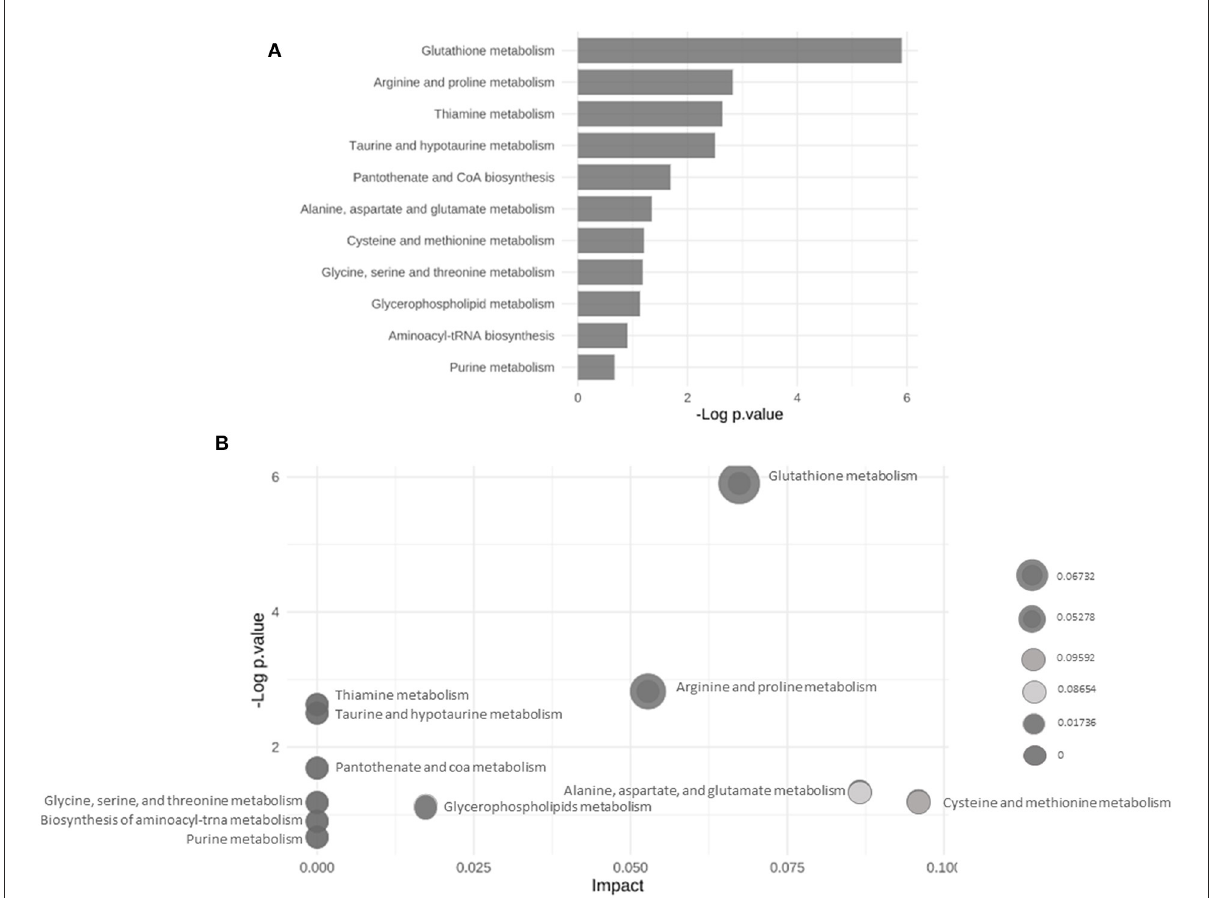
FIGURE5 (A) Bar chart of the results of the enrichment analyses highlighting the altered metabolic pathways in the control and IUGR rat lung tissue samples harvested on postnatal day 7. (B) Bubble plot of the results of pathway enrichment of the control and IUGR rat lung tissue samples harvested on postnatal day 7 ( n =